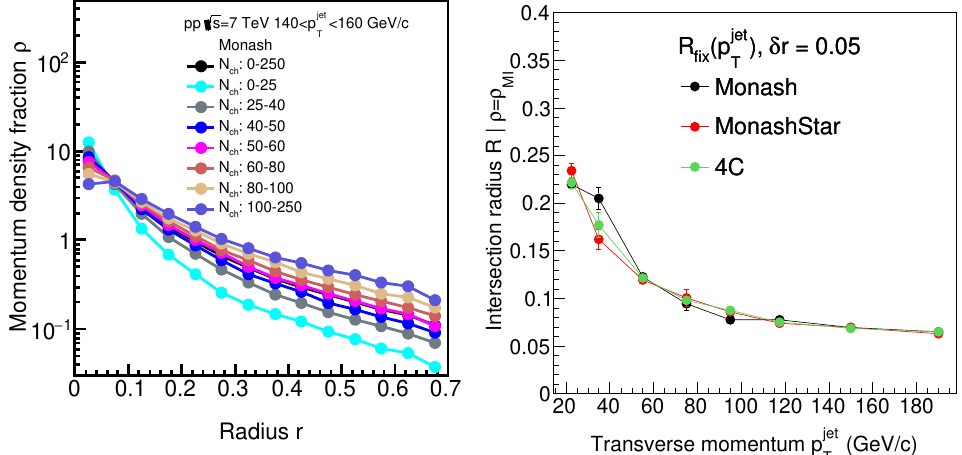
Figure 5. ( Left ) The differential jet shape for many different multiplicity bins with finer ( δ r = 0.05) binnings; ( Right ) The p jet dependence of R fix with finer ( δ r = 0.05) binnings. T